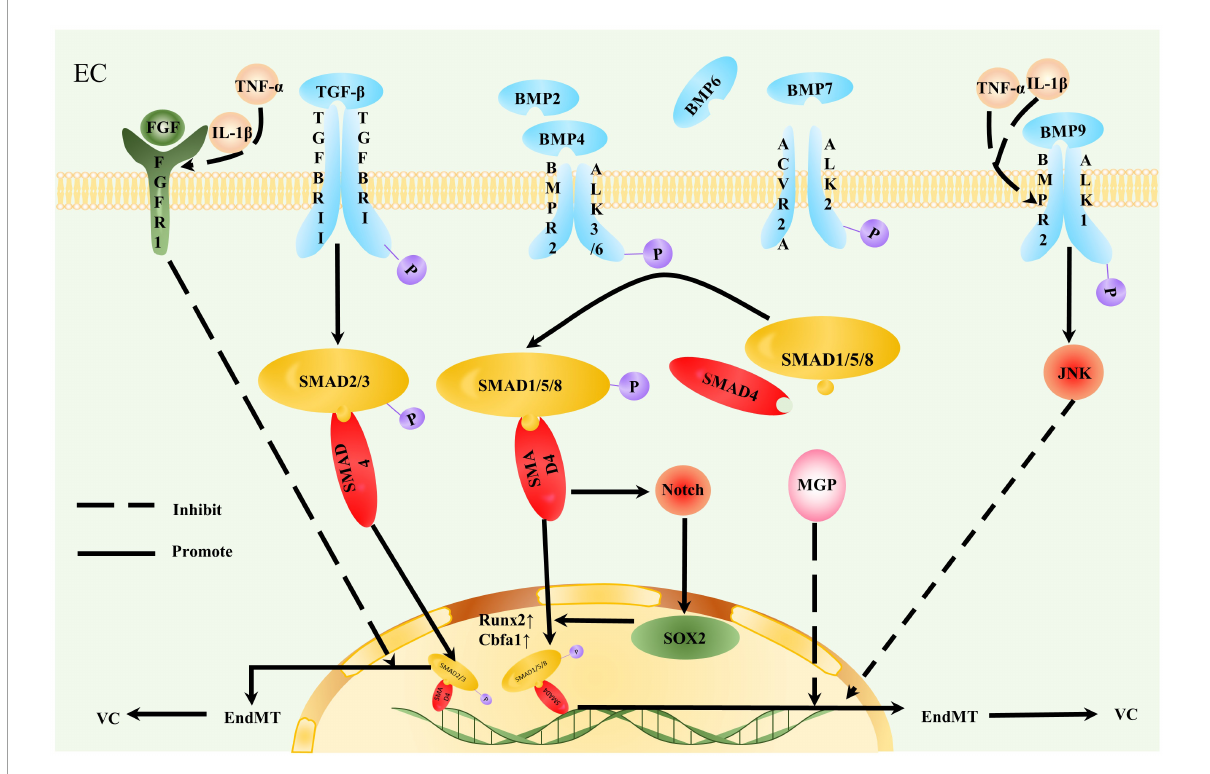
FIGURE3 Contribution of endothelial-to-mesenchymal transition to vascular calcification. Endothelial cells (ECs) undergoing endothelial-to-mesenchymal transition (EndMT) are more likely to participate in vascular calcification (VC). TGF- β and bone morphogenetic protein (BMP) act on a tetrameric receptor complex to induce Smad-dependent signaling and regulate VC. TGF- β induces TGFBRII to activate TGFBRI. Type I receptors recruit and activate downstream Smad2/3/4 and Smad protein complexes to gather in the nucleus and act as transcriptional factors, thereby promoting VC. Inflammation stimulates decreased FGFR1 expression levels in EC. Interrupted fibroblast growth factor (FGF) signal transduction increases TGFBRI expression, loses the effective inhibition of TGF- β cascade reaction, and initiates EndMT. BMP transmits osteogenic signals by binding to activin receptor-like kinase (ALK)1/2/3/6 and phosphorylating Smad1/5/8. Smad1/5/8 and Smad4 form a quaternary complex isomer complex and translocate to the nucleus to promote osteogenic gene Runx2/Cbfa1 expression. The inflammatory factors, TNF- α and IL-1 β , downregulate BMPR2 in aortic ECs, rendering ECs sensitive to osteogenic differentiation promoted by BMP9. TNF- α and IL-1 β also promote EndMT by reducing JNK signal transduction. The calcification inhibitor matrix Gla protein (MGP) suppressed the effect of BMP2/4. Increased BMP4 expression also induces MGP expression; therefore, this negative feedback inhibits BMP2 and 4 osteogenesis. MGP deletion promotes EndMT. SOX2 is closely related to the osteogenic differentiation of ECs. BMP enhances